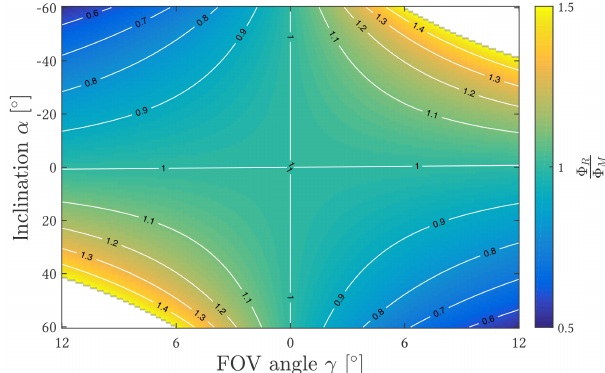
Figure 6. Deviation of the total true flux from the measured flux (with no inclination assumed) as a function of the FOV angle of the SO 2 camera and the inclination angle α . A perspective imaging of a plume with unknown inclination can lead to wrong flux estimations. Deviations larger than 0.5 from the measured data are shaded white. White stripes show the 0.1 steps of the deviations.